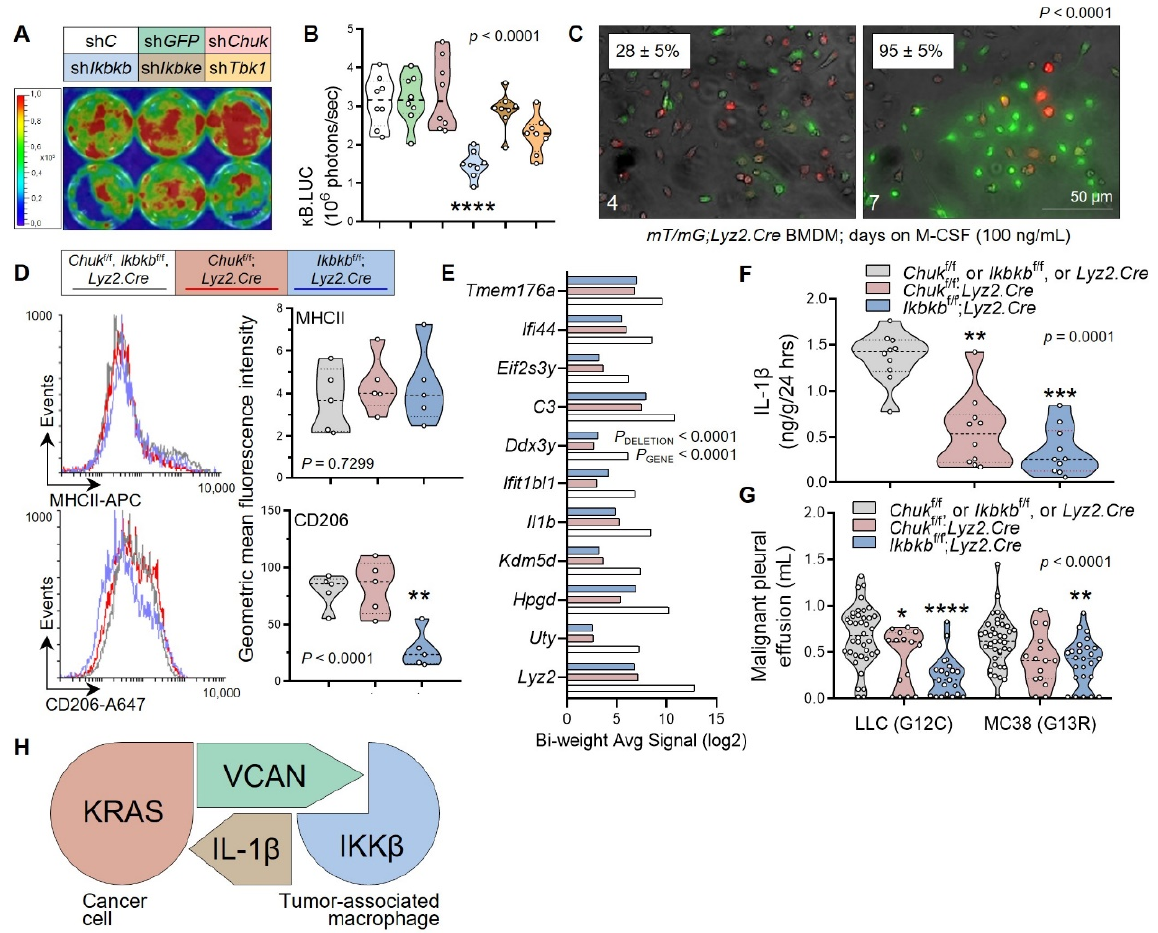
Figure 5. IKK β mediates pro-tumor NF- κ B activity, differentiation, and IL-1 β secretion in macro- phages. ( A , B ) Bioluminescent image with pseudo color scale ( A ) and data summary ( B ) of p NGL RAW264.7 cells 72 h post-infection with control (sh C ), anti-GFP (sh GFP ), or anti-inhibitor of NF- κ B kinase (sh Chuk , sh Ikbkb , sh Ikbke , or sh Tbk1 )-specific shRNAs. n = 8 independent experiments/group; P , probability, one-way ANOVA; ****, p < 0.0001 compared with sh C , Bonferroni post-tests. ( C – F ) Bone marrow-derived macrophages (BMDM) were derived from mT/mG; Lyz2.Cre , Chuk f/f ; Lyz2.Cre , and Ikbkb f/f ; Lyz2.Cre mice using one-week exposure to 100 ng/mL M-CSF. Shown are images and mean ± SD % green cells of bone marrow cells from mT/mG; Lyz2.Cre mice during/after weekly treat- ment with M-CSF ( C ), flow cytometric histograms (left) and data summary (right) of marker expres- sion ( D ), top-differentially expressed genes by microarray ( E ), and interleukin (IL)-1 β secretion by ELISA ( F ). ( C , D ) n = 5 independent experiments/group; P , probability, Fisher’s exact test or one-way ANOVA; **, p < 0.01 compared with other groups, Bonferroni post-tests. ( E ) n = 1 pooled tripli- cate/group; P , probabilities, two-way ANOVA. ( F ) n = 10 independent experiments; P , probability, one-way ANOVA; ** and ***, p < 0.01 and p < 0.001, respectively, compared with controls, Bonferroni post-tests. ( G ) Chuk f/f ; Lyz2.Cre and Ikbkb f/f ; Lyz2.Cre mice received intrapleural LLC or MC38 cells,